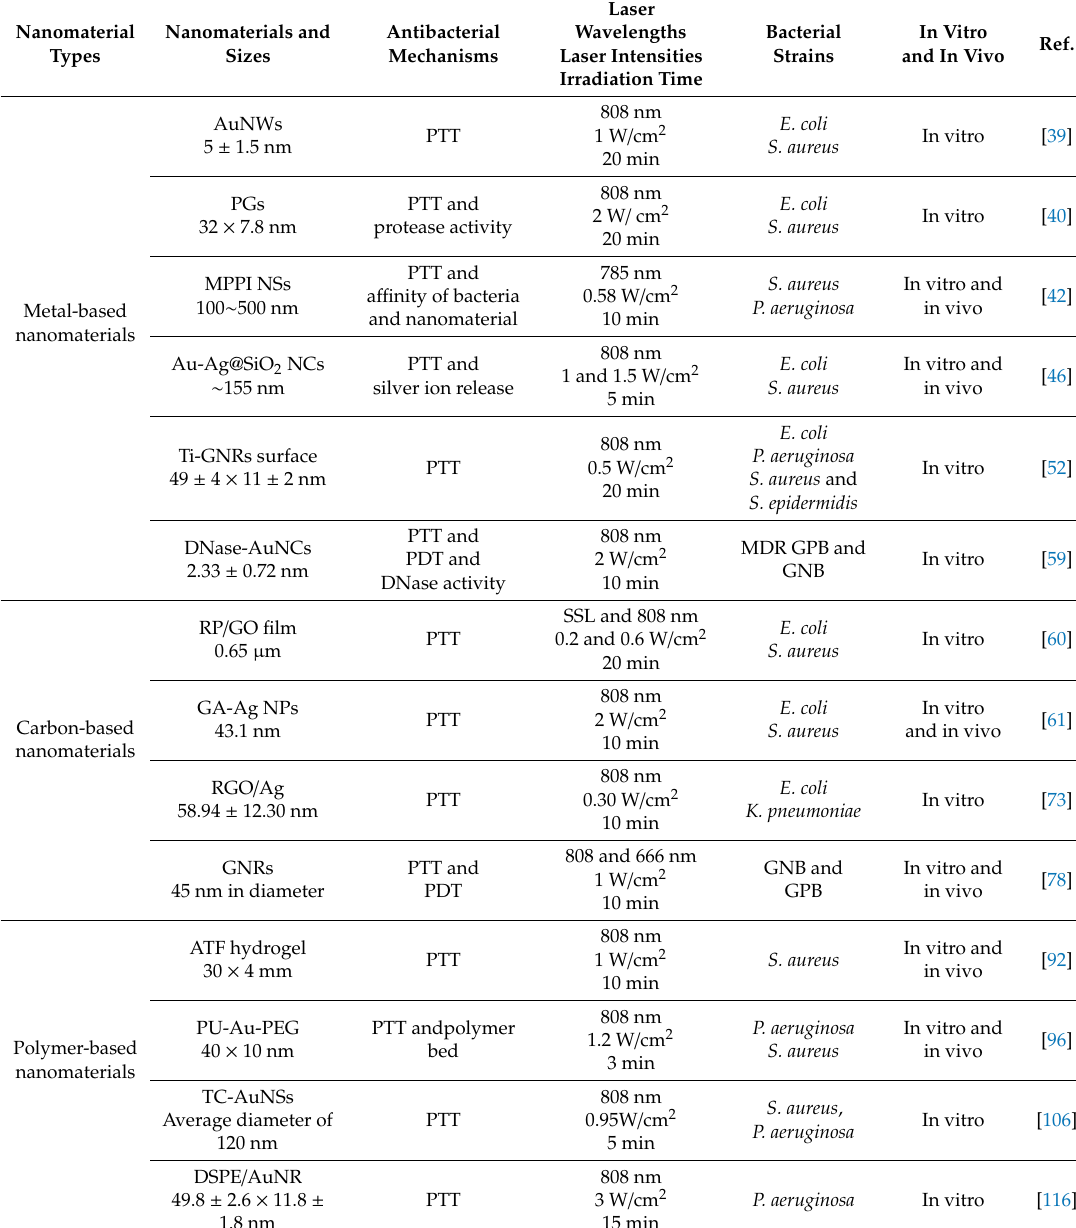
Table 1. Comparison of nanomaterials with photothermal e ff ects as antibacterial